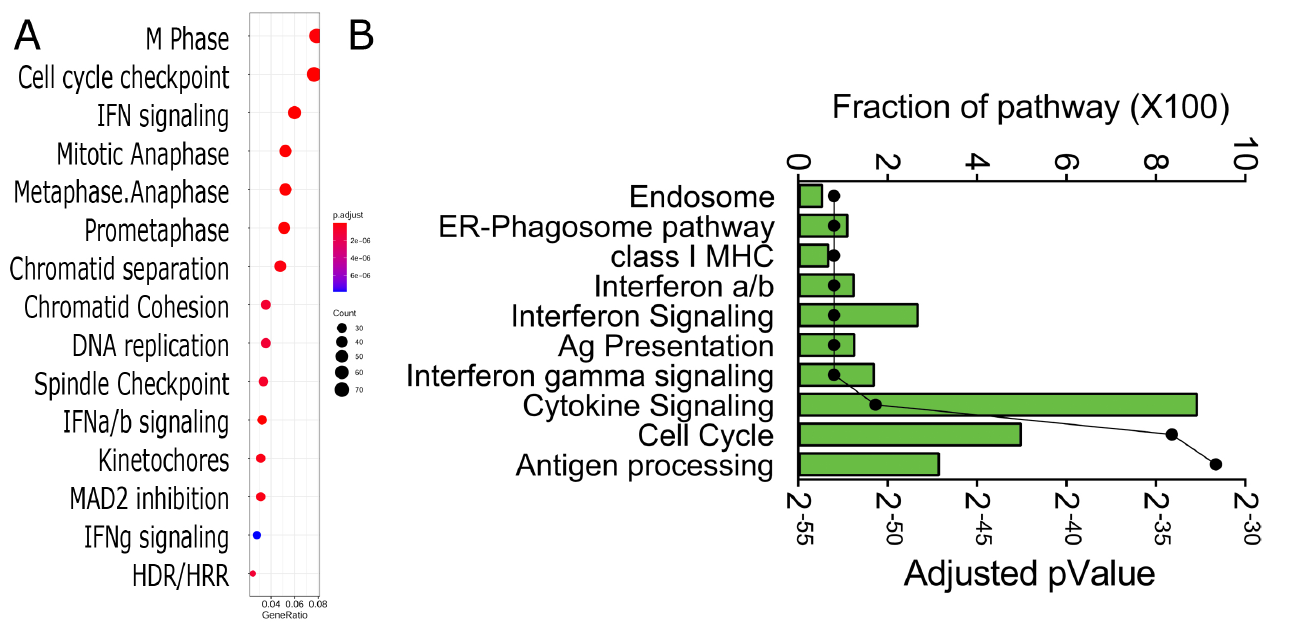
Figure 5. Pathway analysis of differentially expressed DIU transcripts. ( A ) Shown are genome ontologies of enriched DIU transcripts ranked by the number of genes (gene ratio) and by enrichment relative to the genome (pValue). ( B ) Biological pathways of DIUs. For each pathway are shown the fraction of the pathway contained within the DIU transcript list and the adjusted p